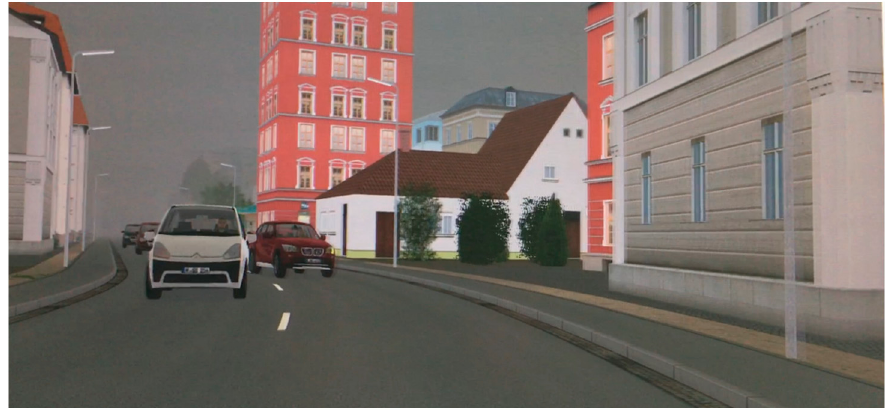
Figure 1. A screenshot of the driving simulation during one of three threatening traffic events in the fear scenario, where participants were faced with a car swerving into the ego lane during an overtaking